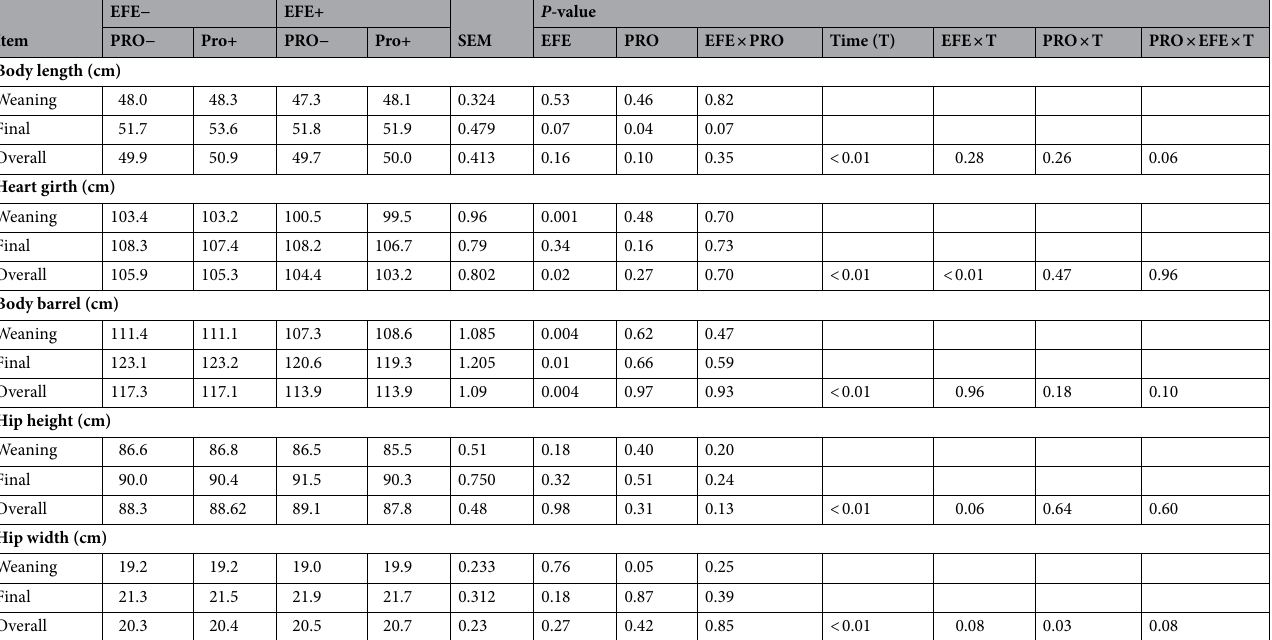
Table 3. Least squares means for body measurements in dairy calves supplemented with or without exogenous fibrolytic enzymes (EFE) and probiotic (PRO) in the starter diets (n = 12 calves per treatment). Treatments were (1) calves fed diets without exogenous fibrolytic enzymes (EFE)-treated wheat straw and probiotic supplement (EFE-Pro−), (2) calves fed diets of EFE-treated wheat straw but with probiotic supplement (2 g/d/calf; EFE-Pro+), (3) calves fed EFE-treated wheat straw (2 g/d/calf) but without probiotic supplement (EFE+ Pro−), (4) calves fed EFE-treated wheat straw and probiotic supplement (EFE+ Pro+). Exogenous fibrolytic enzymes were applied to wheat straw.